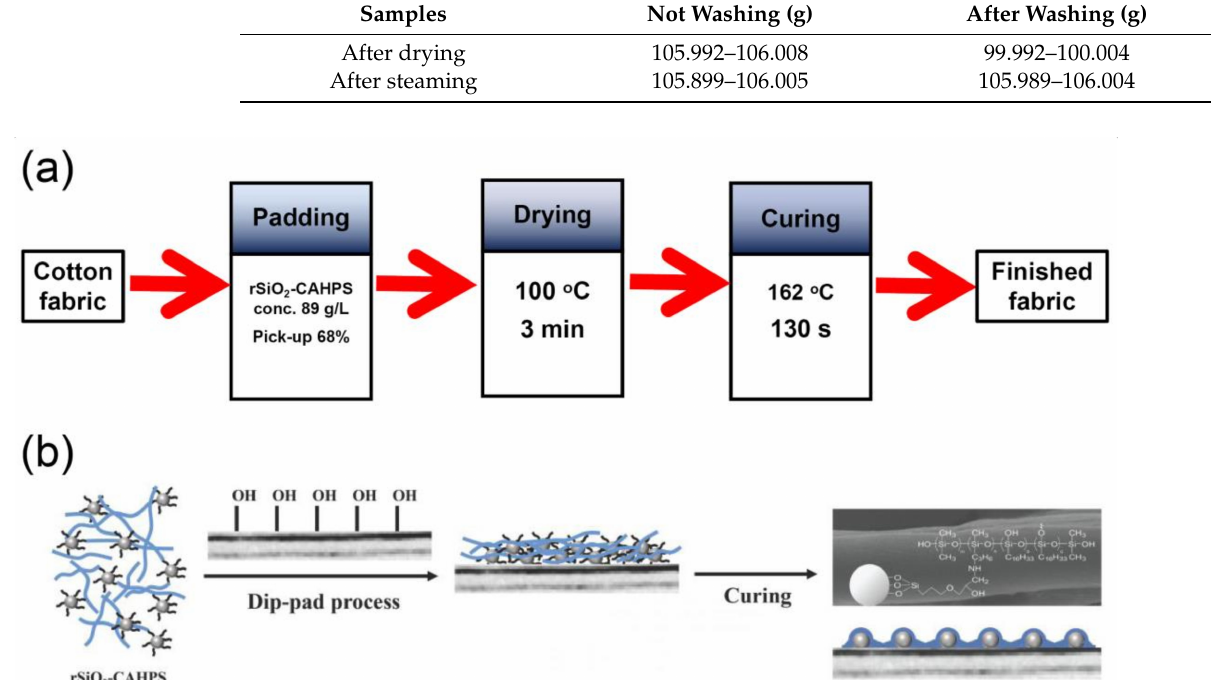
Scheme 2. Finishing flowchart ( a ) and schematic illustration of film formation of rSiO 2 -CAHPS on cotton fiber ( b